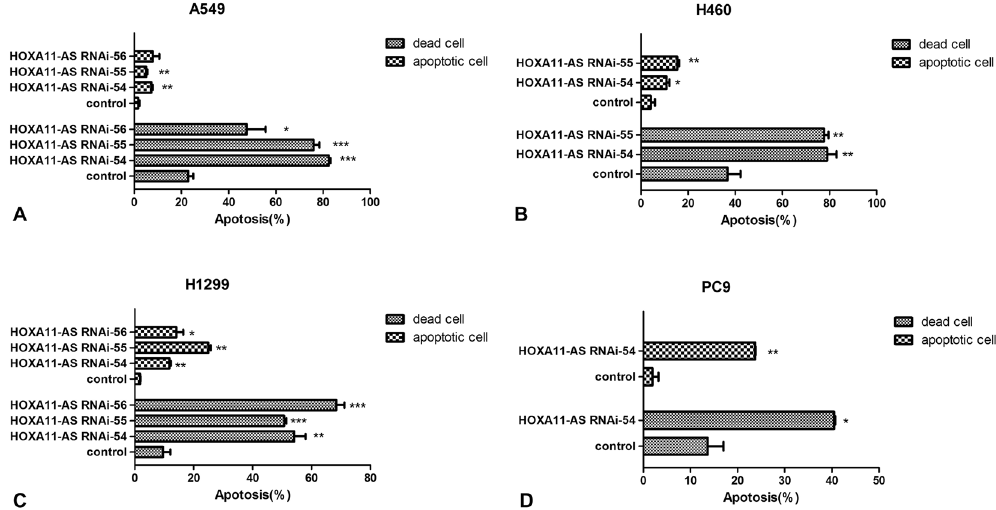
Figure 9. HOXA11-AS RNAi promoted apoptosis in A549, H1299, H460 and PC9 cell lines based on a flow cytometry assay. (Note: control, lenti-control virus). ( A ) Comparison of the apoptosis rate and mortality rate of A549 cells after silencing HOXA11-AS expression ( * P < 0.05, ** P < 0.01, *** P < 0.001). ( B ) Comparison of the apoptosis rate and mortality rate of H460 cells after silencing HOXA11-AS expression ( * P < 0.05, ** P < 0.01, *** P < 0.001). ( C ) Comparison of the apoptosis rate and mortality rate of H1299 cells after silencing HOXA11-AS expression ( * P < 0.05, ** P < 0.01, *** P < 0.001). ( D ) Comparison of the apoptosis rate and mortality rate of PC9 cells after silencing HOXA11-AS expression ( * P < 0.05, ** P < 0.01, *** P < 0.001).